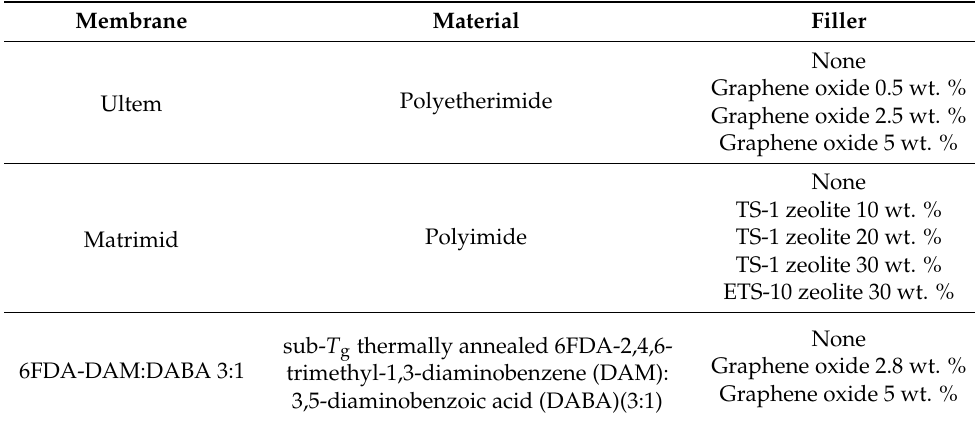
Table 3. Description of the tailor-made membranes and the corresponding material and the different fillers